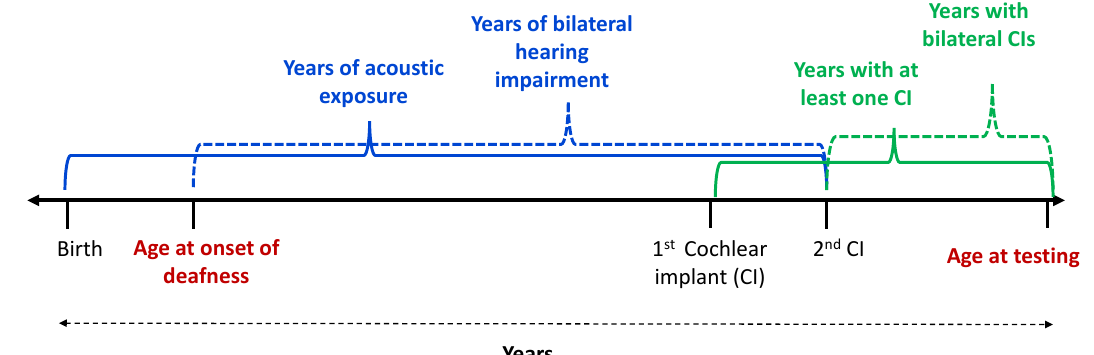
Figure 1. A schematic depicting the calculation for each factor